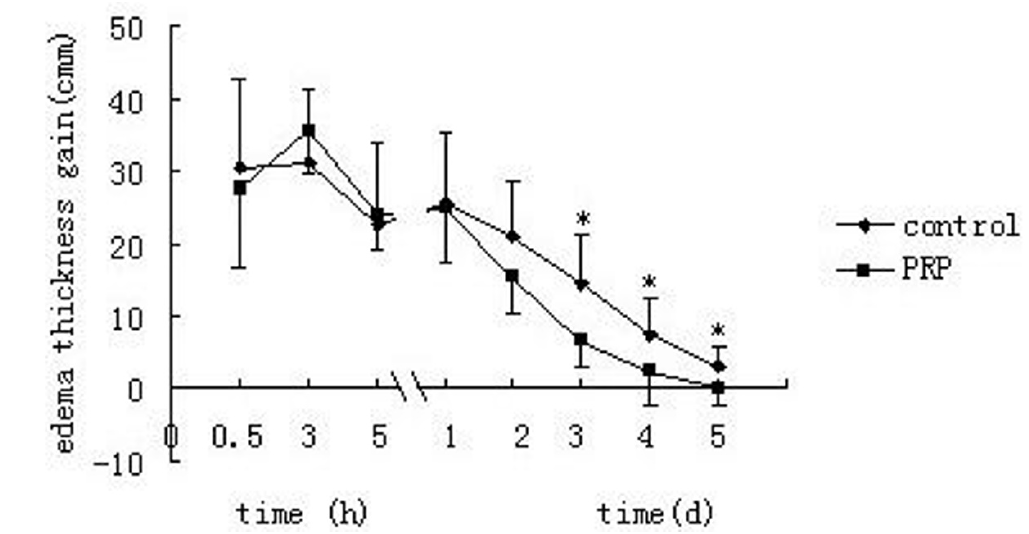
Figure 3 Edema gain after two days . No significant difference within 5 hours. A significant decrease in edema gain after two days (*p <